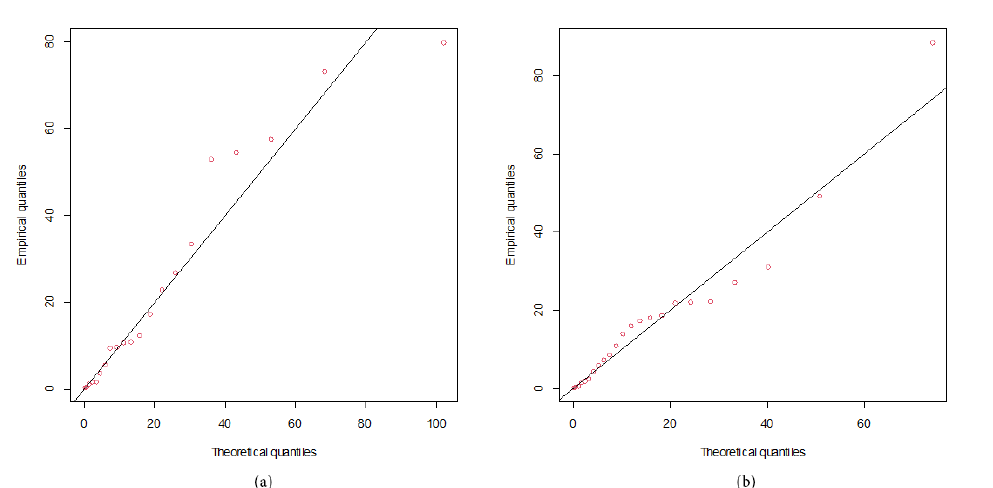
Figure 6. Q-Q plots for distribution fitting of the positive rainfall data from the Song district station, Phrae province, Thailand, for ( a ) January and ( b ) February from 1980–2021. Table 4. The 95% two-sided confidence intervals for the ratio of variances of rainfall datasets from Song district, Phrae province, Thailand. Confidence Intervals for Methods